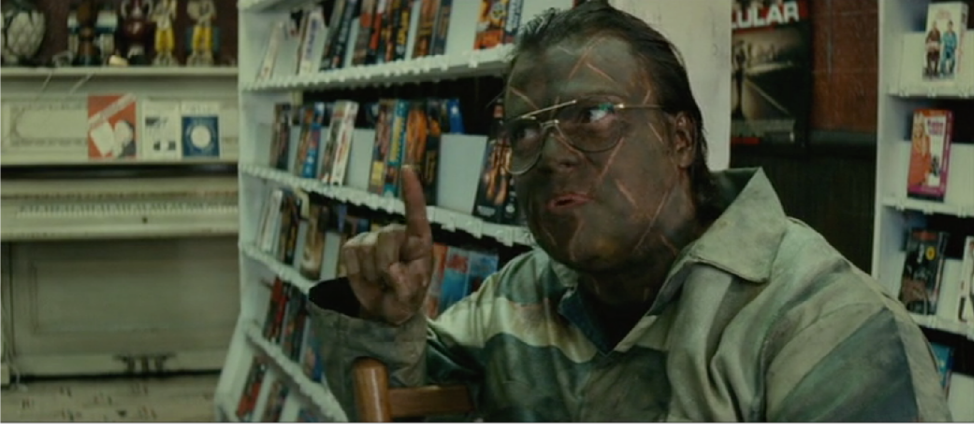
Figure 5. Jerry (Jack Black), in camouflaging face paint, shares his conspiracy theories with Mike at the